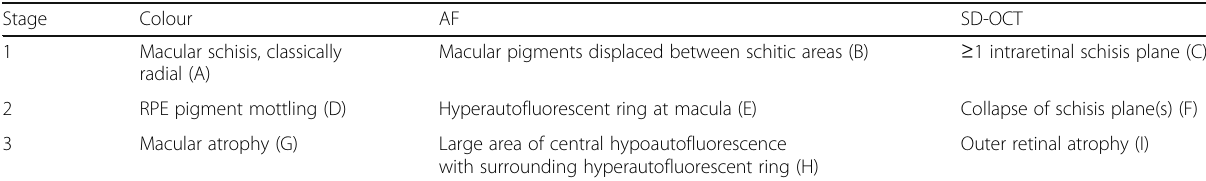
Table 2 The clinical staging of Retinoschisis [14]